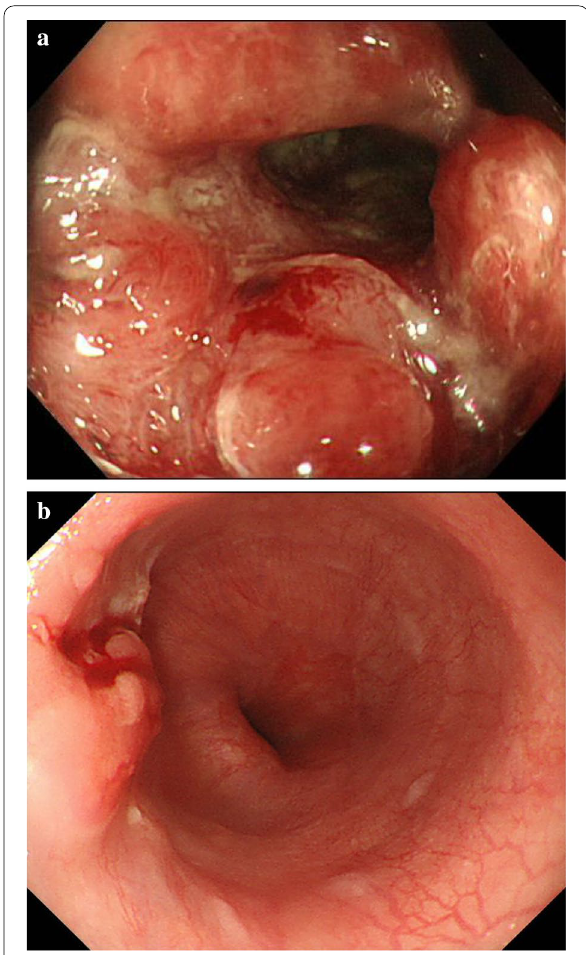
Fig. 1 Endoscopic findings at presentation. a Colonoscopy revealed a circumferential rectal tumor 7 cm from the anal verge. b Esophagogastroduodenoscopy showed type 0-I cancer that was 36–39 cm from the front